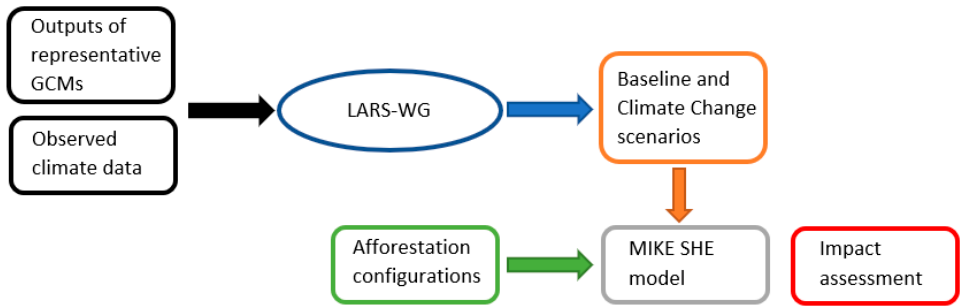
Figure 1. Workflow of impact assessment of the partial afforestation in combination with climate change projections.